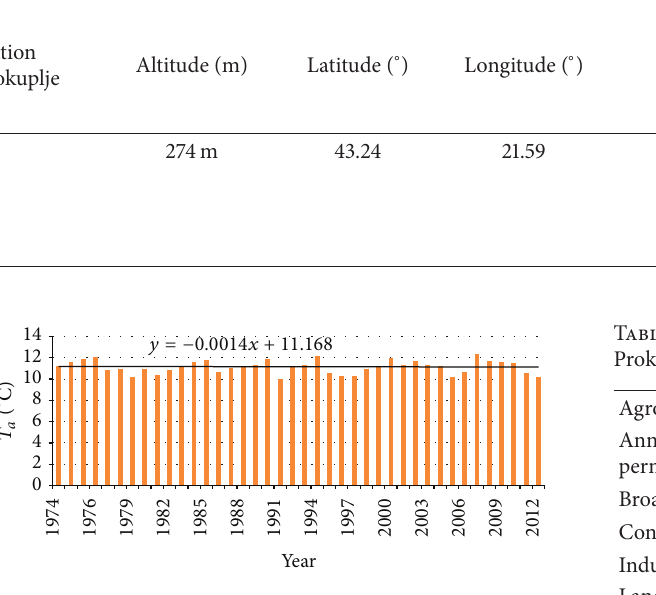
Figure 3: Linear tendency (trend) equation for the period from 1974 to2012foraveragetemperaturesinmeteorologicalstationProkuplje.